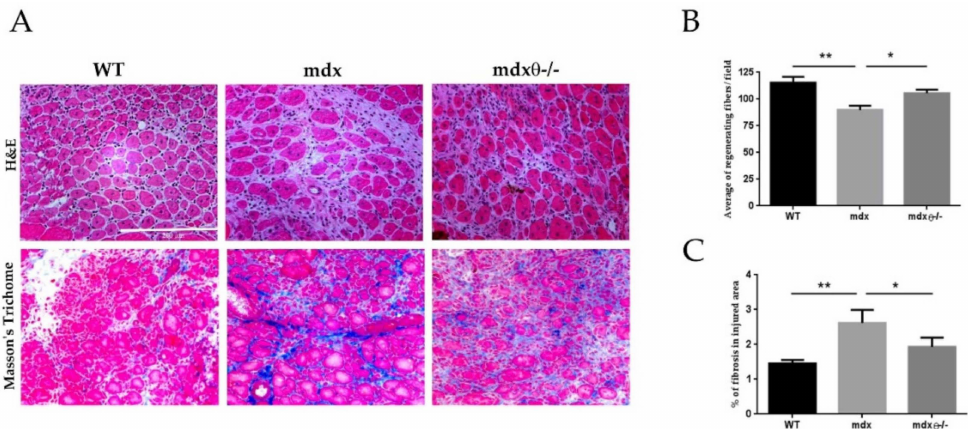
Figure 2. ( A ) Representative image of TA stained with H&E ( upper panels ) and Masson’s trichrome staining ( lower panels ) of 6- month-old WT / bl10 ( n = 3), mdx and mdx θ − / − mice ( n = 5 / genotype), as indicated, at day 7 after CTX injury (bar = 200 µ m). ( B ) Average of number of regenerating fibers